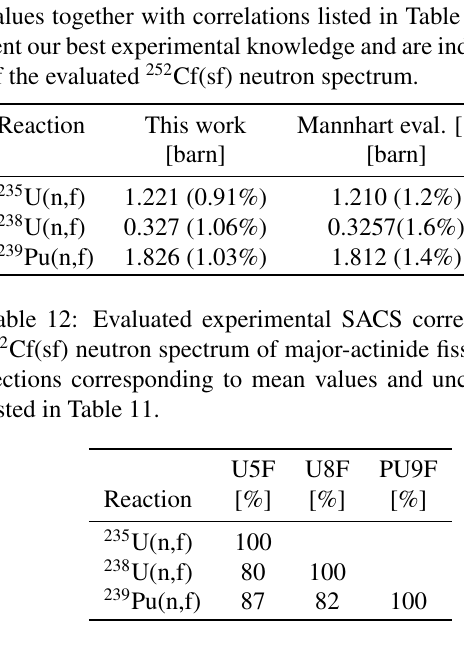
Table 6: Experimental correlations estimated by Mannhart [11] for Grundl-Gilliam SACS data [22–25].